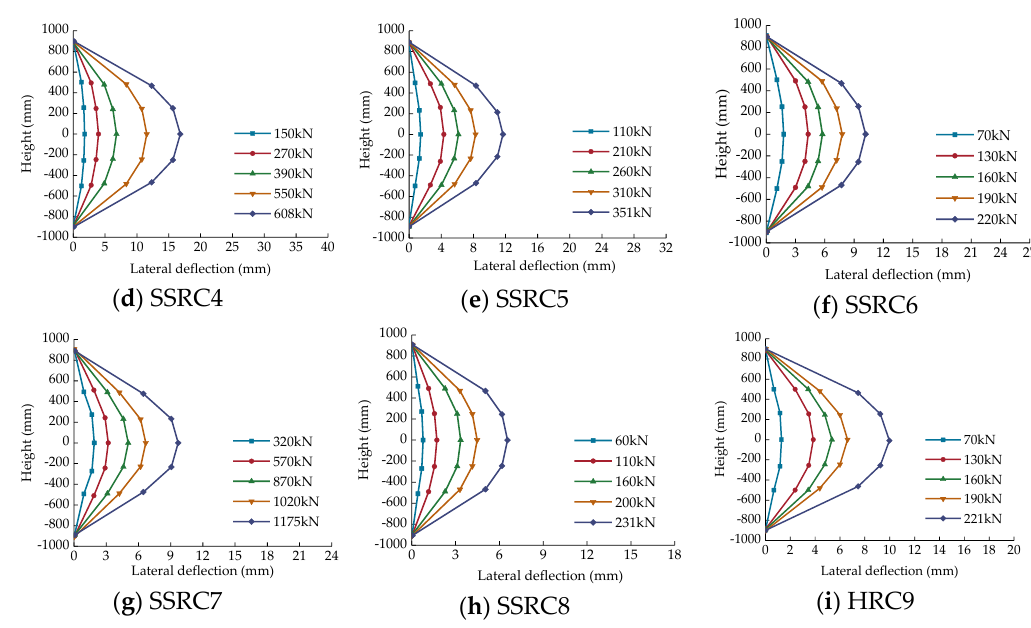
Figure 6. Lateral deflection curves.